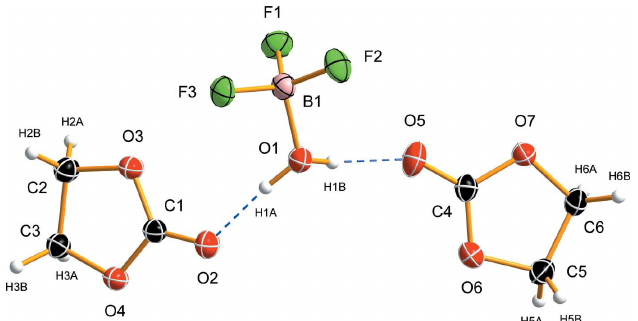
Figure 1 The asymmetric unit and the atom-labelling scheme of the BF 3 H 2 O (cid:2) 2OC(OCH 2 ) 2 co-crystal. Anisotropic displacement ellipsoids are drawn at the 50% probability level, hydrogen atoms are depicted as spheres of arbitrary radius, and hydrogen bonds are indicated by blue dashed lines.